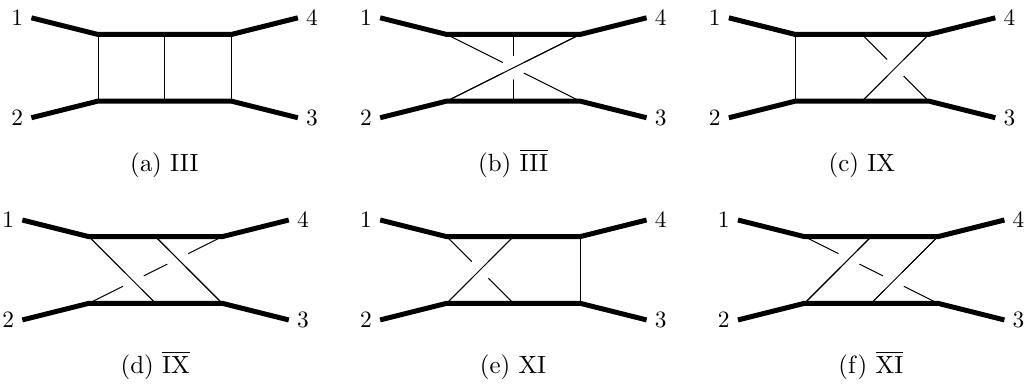
Figure 4. Two loop integrals that are of the double-box type.